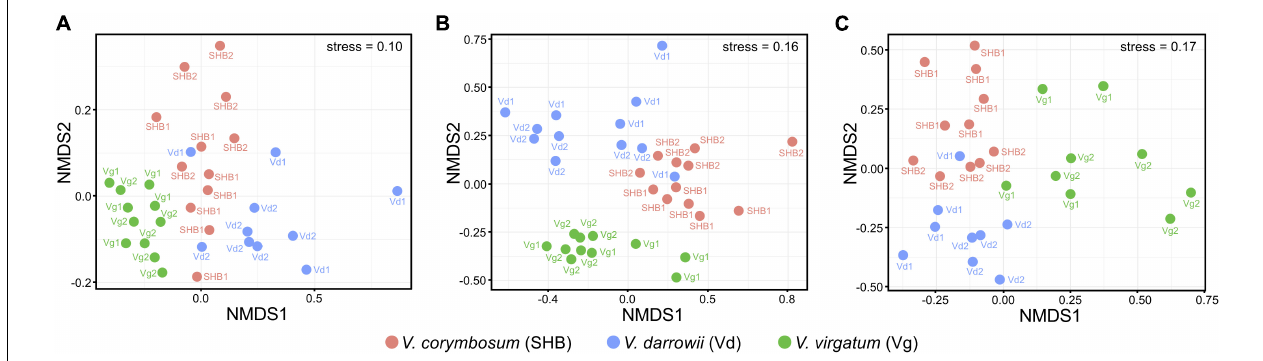
FIGURE 3 | Ordination of bacterial (A) , fungal (B) , and eukaryotic (C) components of the blueberry rhizobiome by the non-metric multidimensional scaling (NMDS) analysis based on Bray–Curtis dissimilarity matrices. Samples from different Vaccinium genotypes are color-coded and labeled as follows: Vg1, V. virgatum MS 1089; Vg2, V. virgatum MS 1408; SHB1, V. corymbosum MS 2337; SHB1, V. corymbosum MS 2276; Vd1, V. darrowii B0008; Vd2, V. darrowii